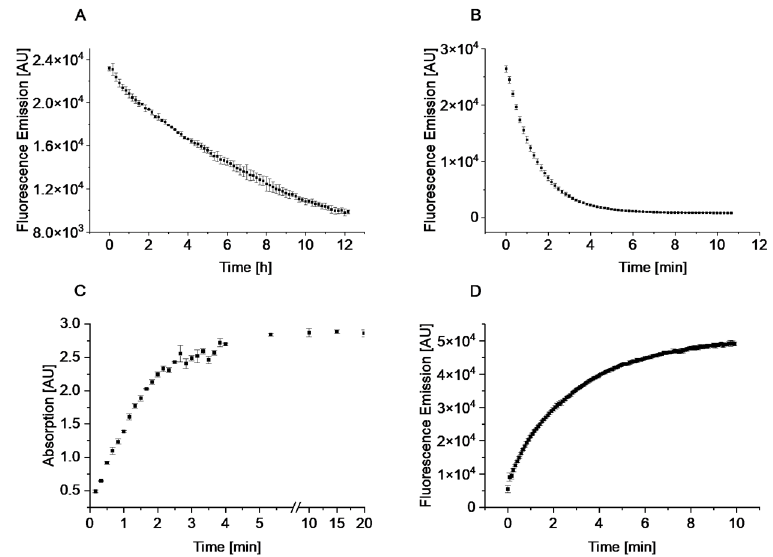
Figure 3. Photometric detection of β -glucosidase surrogate substrate hydrolysis in liquid assays. Shown are the resulting changes of signal intensity after the addition of almond β -glucosidase to a final concentration of 0.23 U mL − 1 to 100 µL of a 5 mM glycoside solution (( A ) arbutin, ( B ) esculin, ( C ) pNPG, ( D ) 4-MUG). Used wavelengths are given in the material and methods section. Experi- ments were conducted in triplicates. The values represent the mean values of three experiments and respective standard deviations.